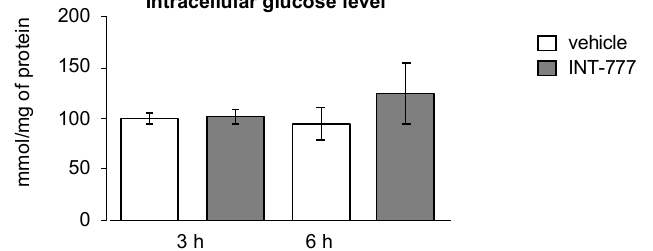
Figure 4. TGR5 did not regulate glucose metabolism in the mouse Leydig cell line. Relative intracel- lular levels of glucose in mLTC1 cells normalized to protein concentration 3 h after treatment with vehicle (DMSO) or INT-777. n = 9 to 12. Data are expressed as the means ± SEM. 2.5. TGR5 Regulated Lipid Homeostasis in mLTC1 Mouse Leydig Cells Some regulatory links have been reported between lipid metabolism and TGR5